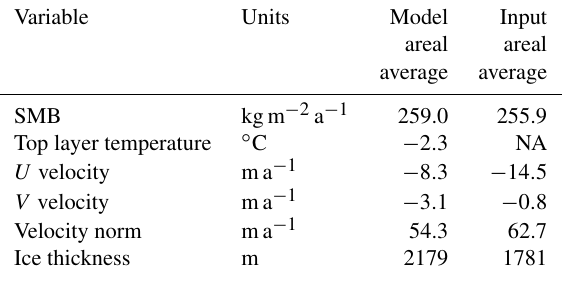
Table 1. Area-weighted and GrIS-masked annual averages for vari- ables from CISM-A model output. “Input areal average” refers to the processed datasets from observations as described in Sect. 2 that are used for the initial state of the model before